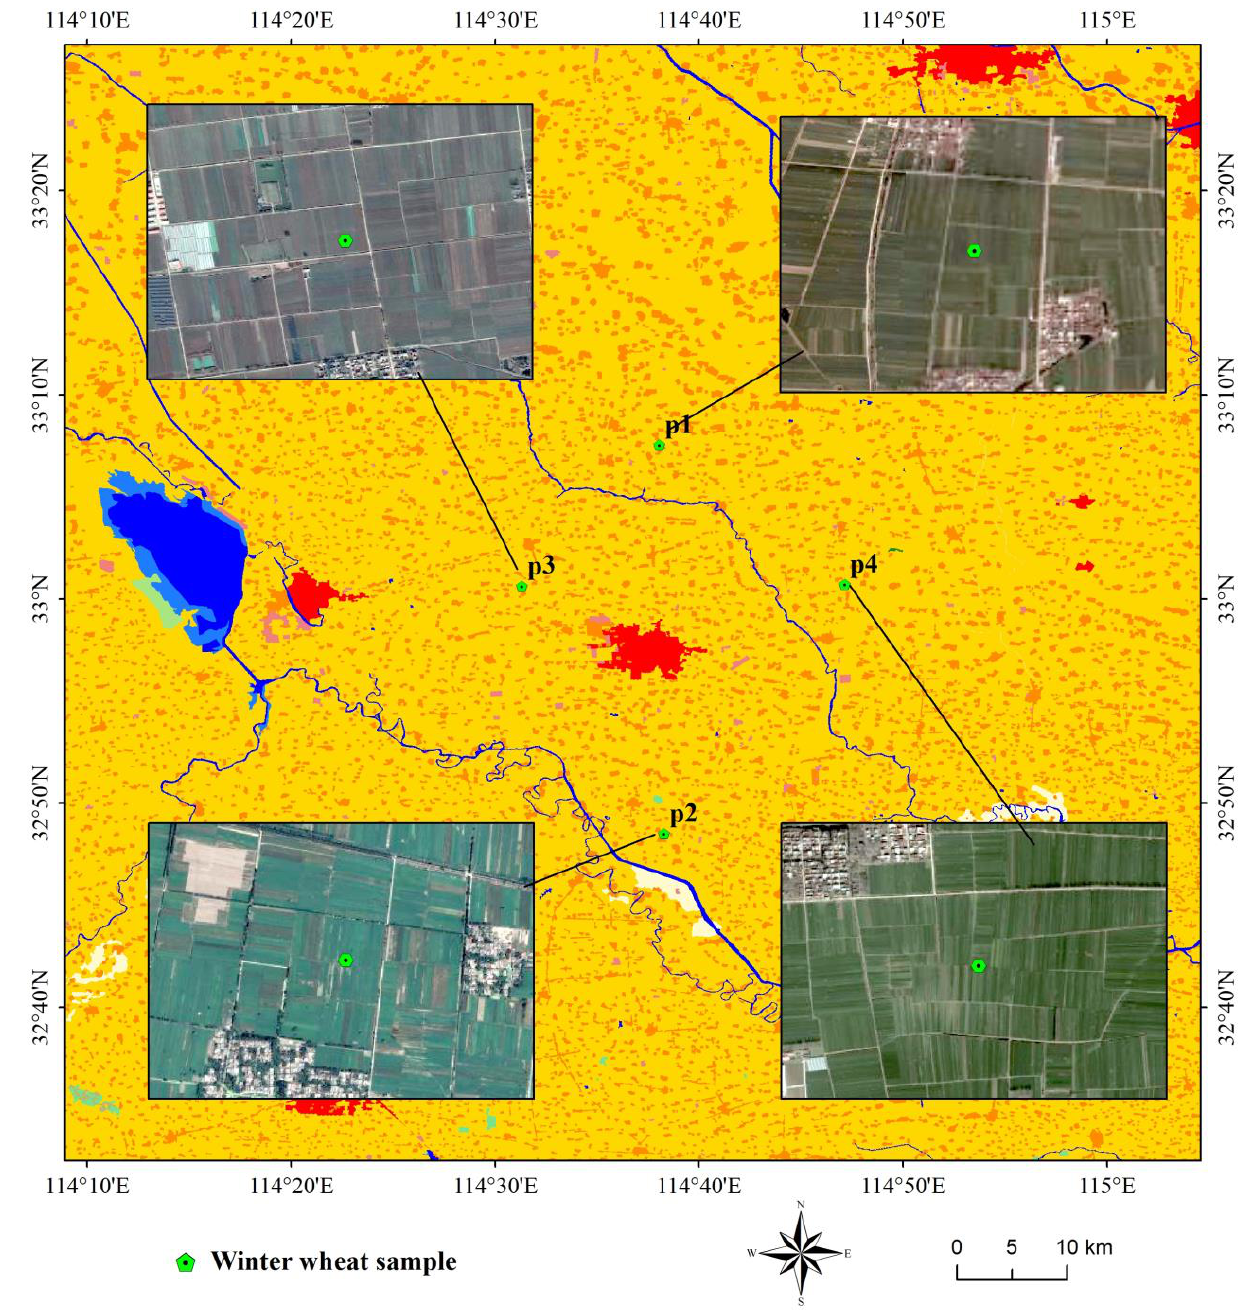
Figure 13. Spatial distribution of winter wheat samples .